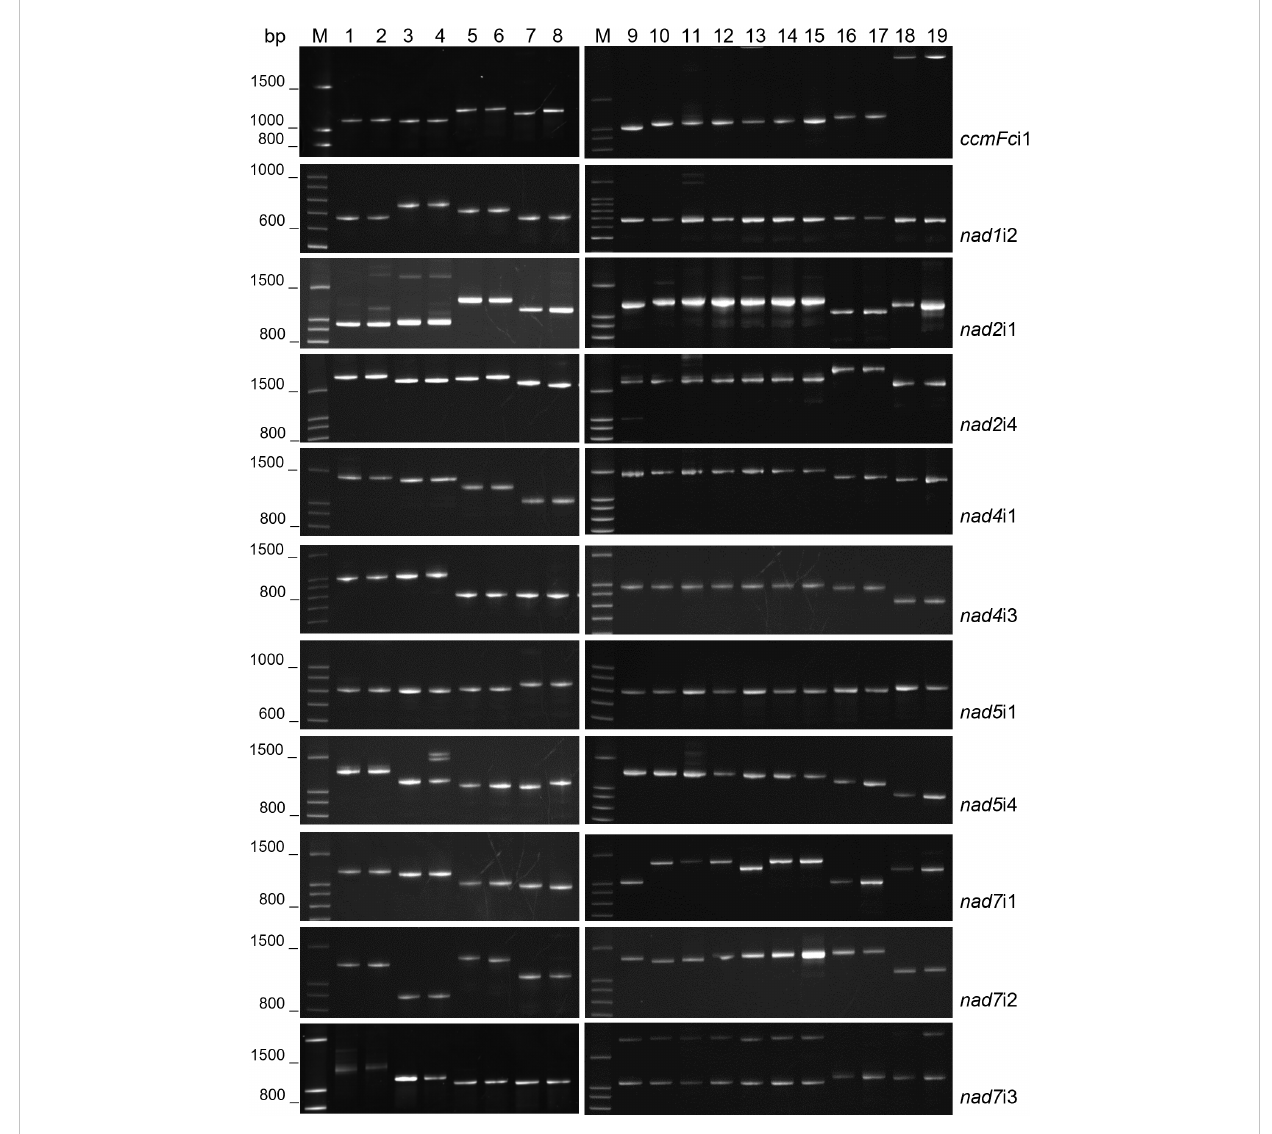
FIGURE 1 Mitochondrial intron lengths vary between but are conserved within plant genera. PCR ampli fi cation products of 11 plant mitochondrial introns were analyzed by polyacrylamide gel electrophoresis. M corresponds to a 100 base pair (bp) DNA ladder. DNA templates for PCR were as follows: 1) Solanum pinnellii LA716, 2) Solanum lycopersicon Bonny Best, 3) Raphanus sativus Red Velvet, 4) Raphanus sativus April Cross, 5) Cynodon dactylon Royal Cape, 6) Cynodon transvaalensis Frankenwald Fine, 7) Cenchrus americanus Ti fl eaf3, 8) Cenchrus purpureus Merkeron, 9) Poncirus